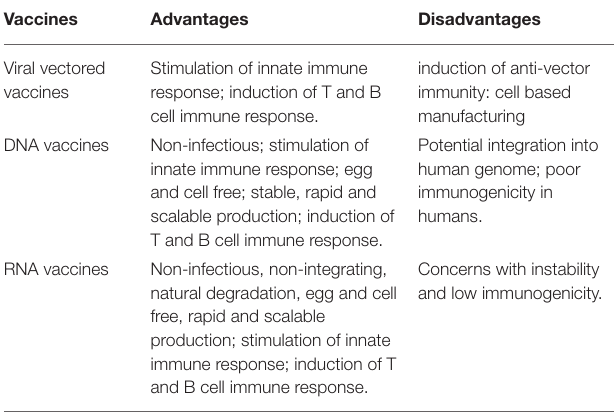
TABLE 1 | Advantages and disadvantages of viral vectored vaccines, DNA vaccines and RNA